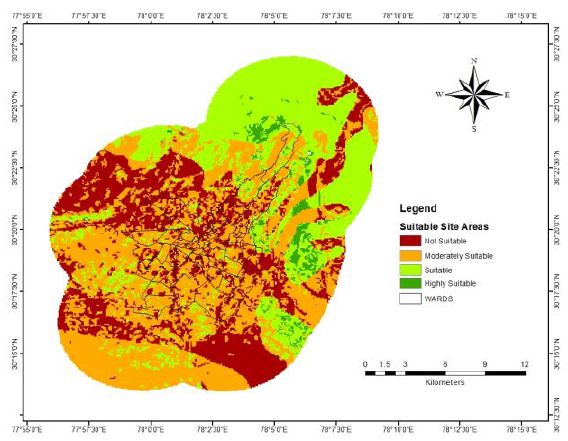
Figure 9. Suitable sites for solid waste disposal (AHP-WLC)